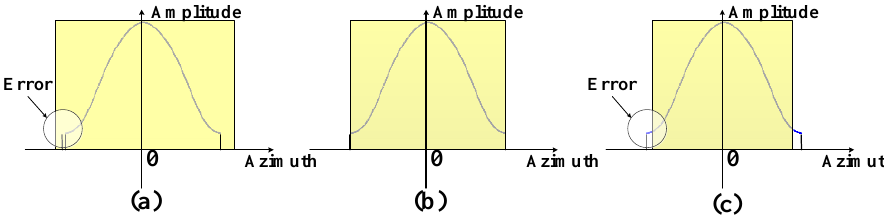
Figure 7. Different errors in the weighting operation. The purple line shows the window and the yellow region is the effective bandwidth that needs to be weighted. ( a ) The length of the window is shorter than the effective bandwidth; ( b ) The length of the window is equal to effective bandwidth; ( c ) The length of window is larger than the effective bandwidth.